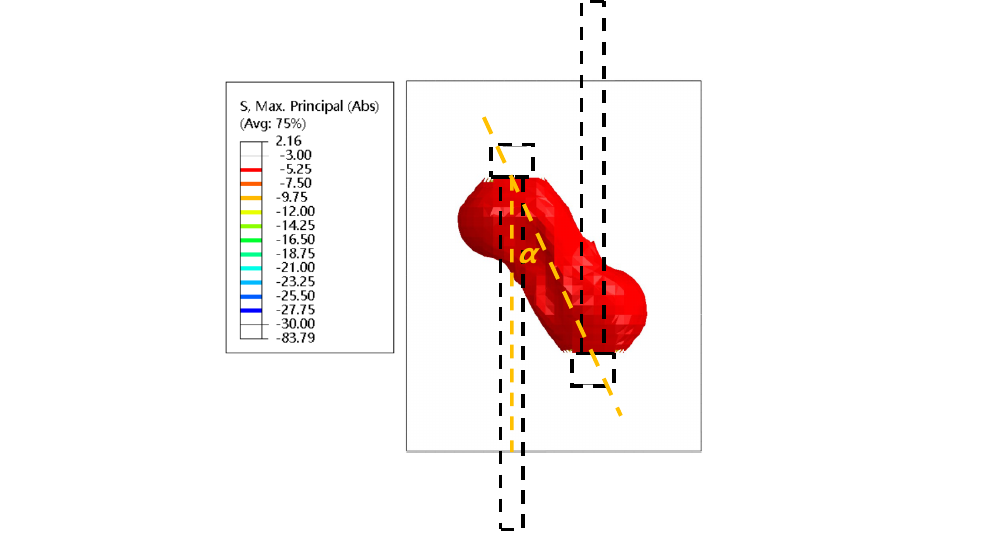
Figure 33. Diagonal compressive strut between two heads.